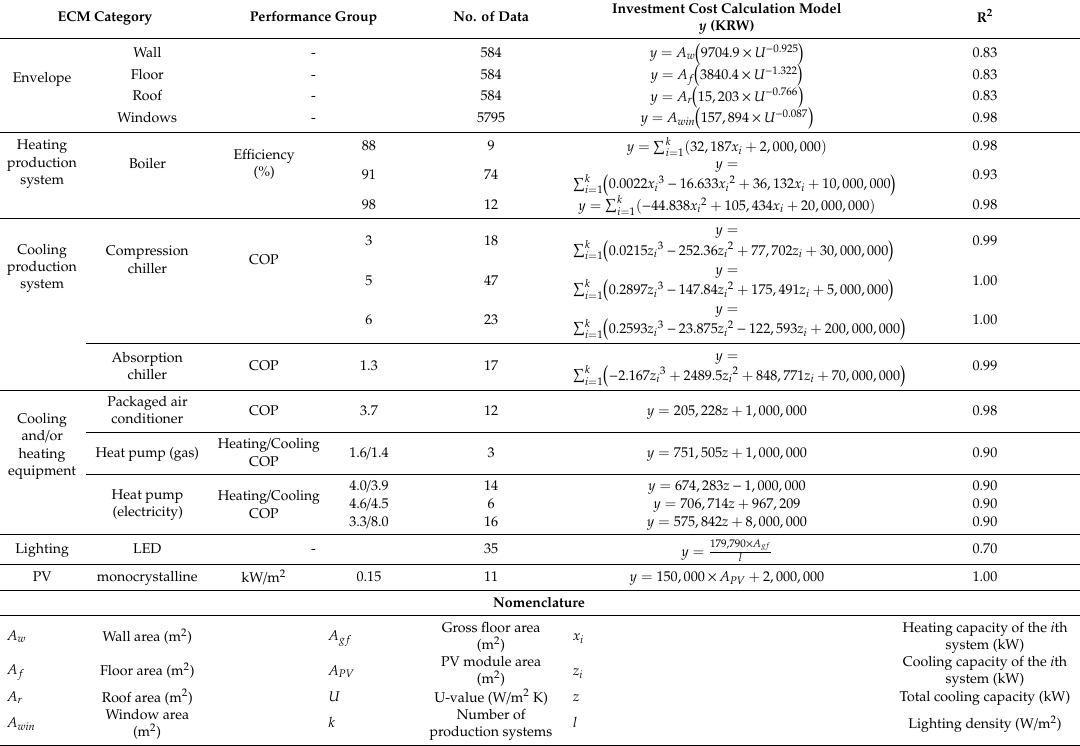
Table 2. The calculation models of ECMs investment